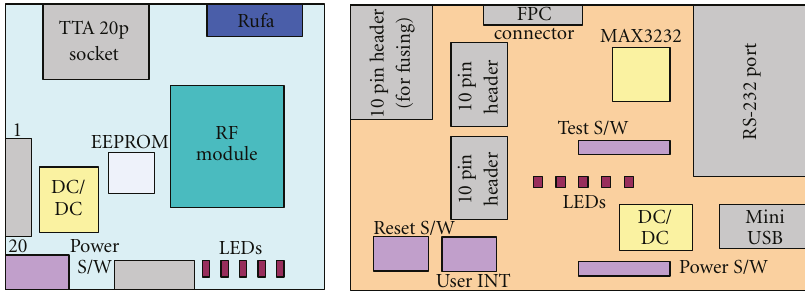
(b) Layout of the prototype and its debugging board Figure 8: The Prototype of the connectivity